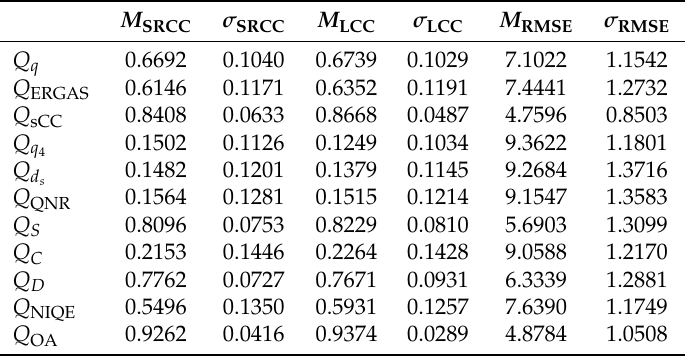
Table 19. Median and standard deviation of the Spearman rank correlation coefficient (SRCC) and the linear correlation coefficient (LCC) between DMOS and spatial quality indices measured over 1000 iterations.